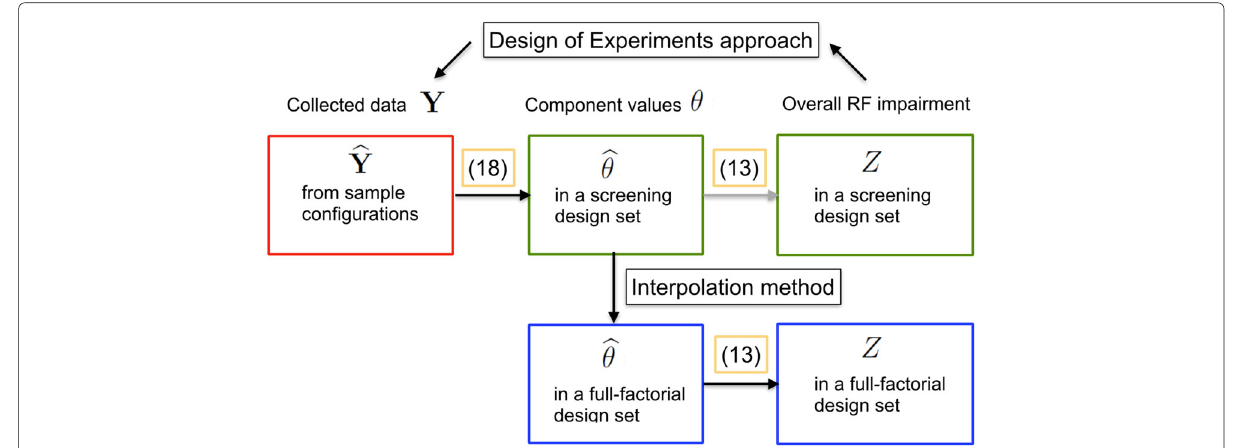
Fig. 6 The flow chart of design of experiments (DoE) and interpolation methods for tackling a large number of